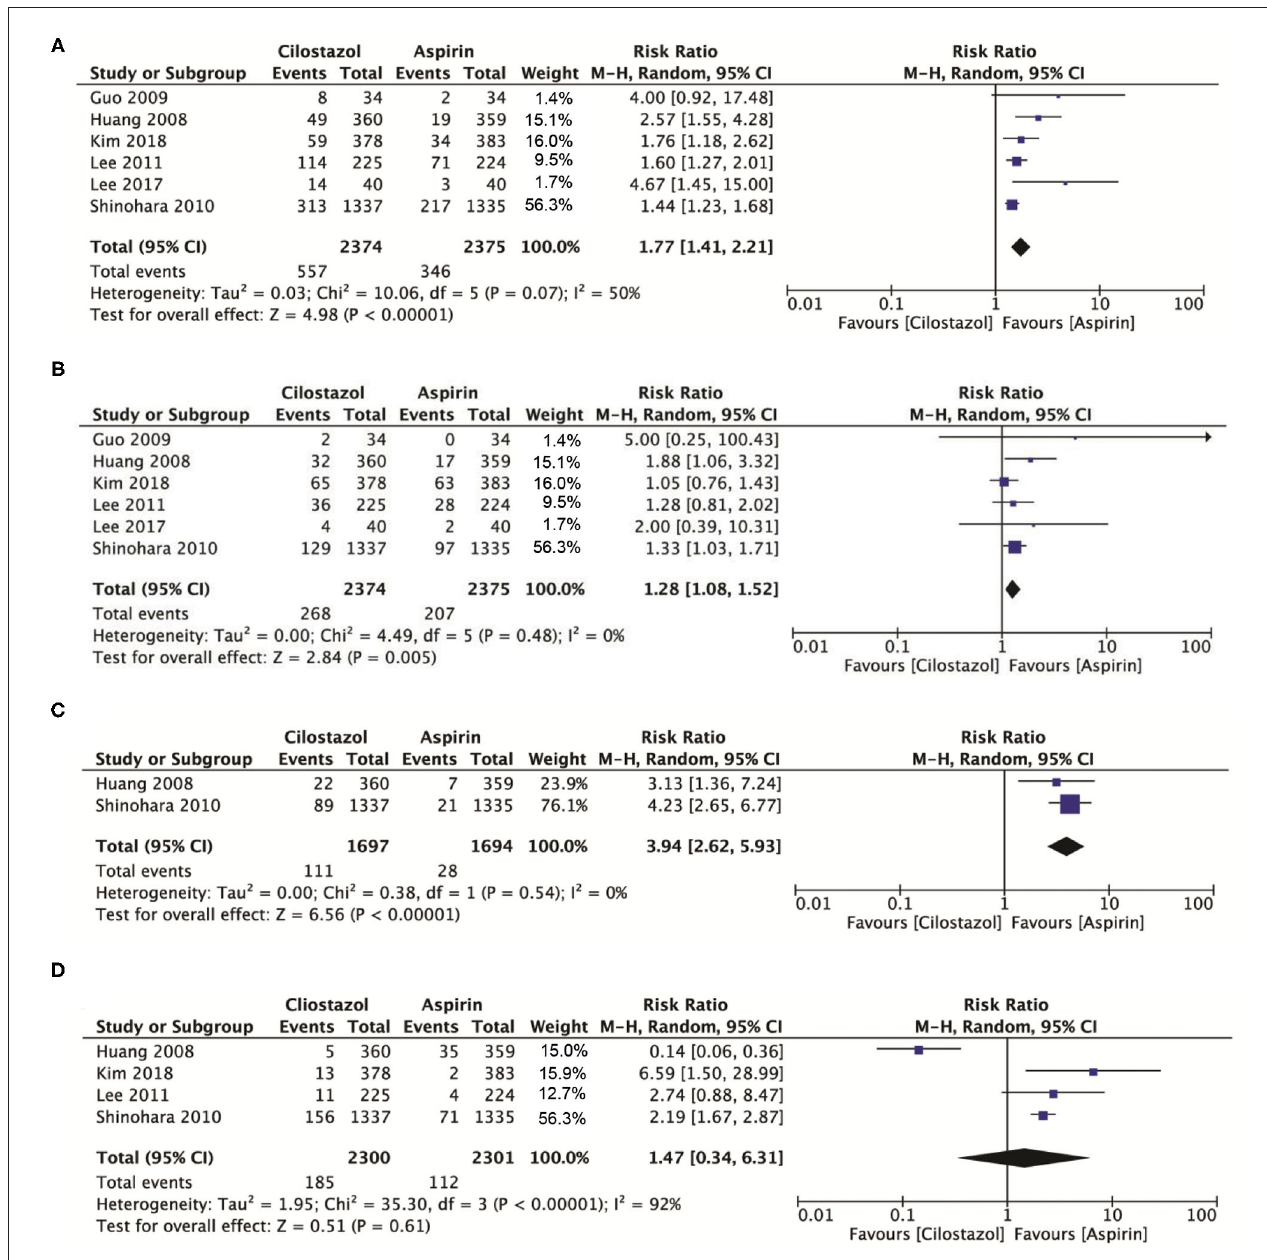
FIGURE 5 | (A) A forest plot of comparison: headache; (B) A forest plot of comparison: dizziness; (C) A forest plot of comparison: tachycardia; (D) A forest plot of comparison: